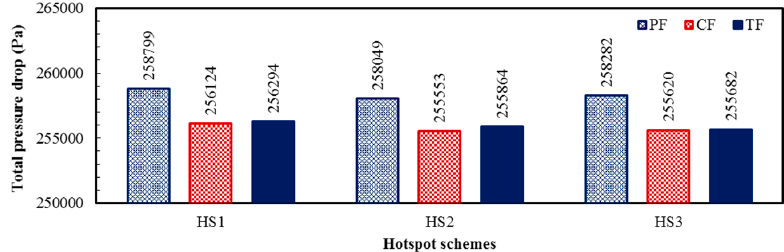
Figure 14. Total pressure drops in the PF, CF, and TF heat sink designs for the HS1, HS2, and HS3 hotspot schemes at the total flow rate of 0.01 kg/s.